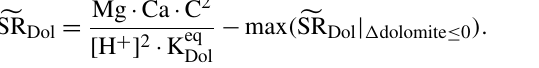
The green-shaded top right quadrant points to dolomite precipitation in initially supersaturated samples; the bottom left blue-shaded quadrant contains solutions initially under- saturated with respect to dolomite and, if present, dissolving. The top left orange-shaded quadrant is the most problematic: dolomite is initially undersaturated but, presumably due